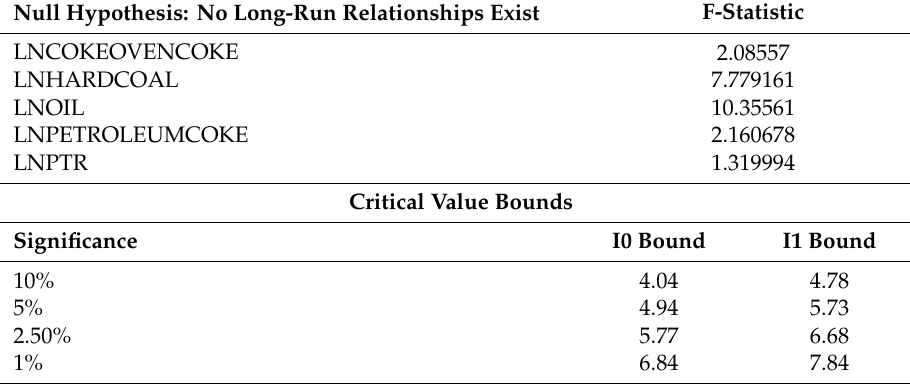
Table 11. The results of the ARDL bounds test.